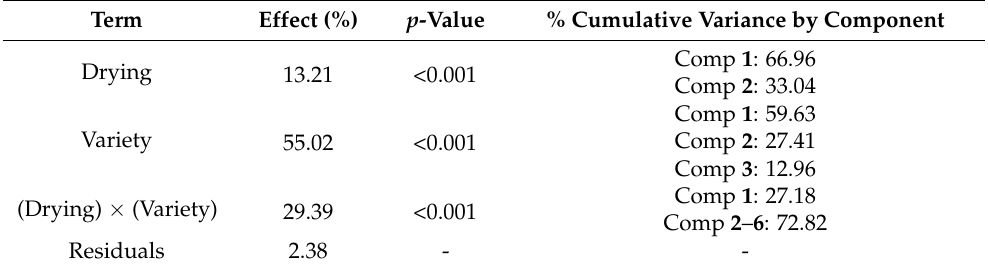
Table 2. ANOVA simultaneous component analysis (ASCA) to evaluate the effect of the main factors, drying and variety, and their interaction on the volatile content of